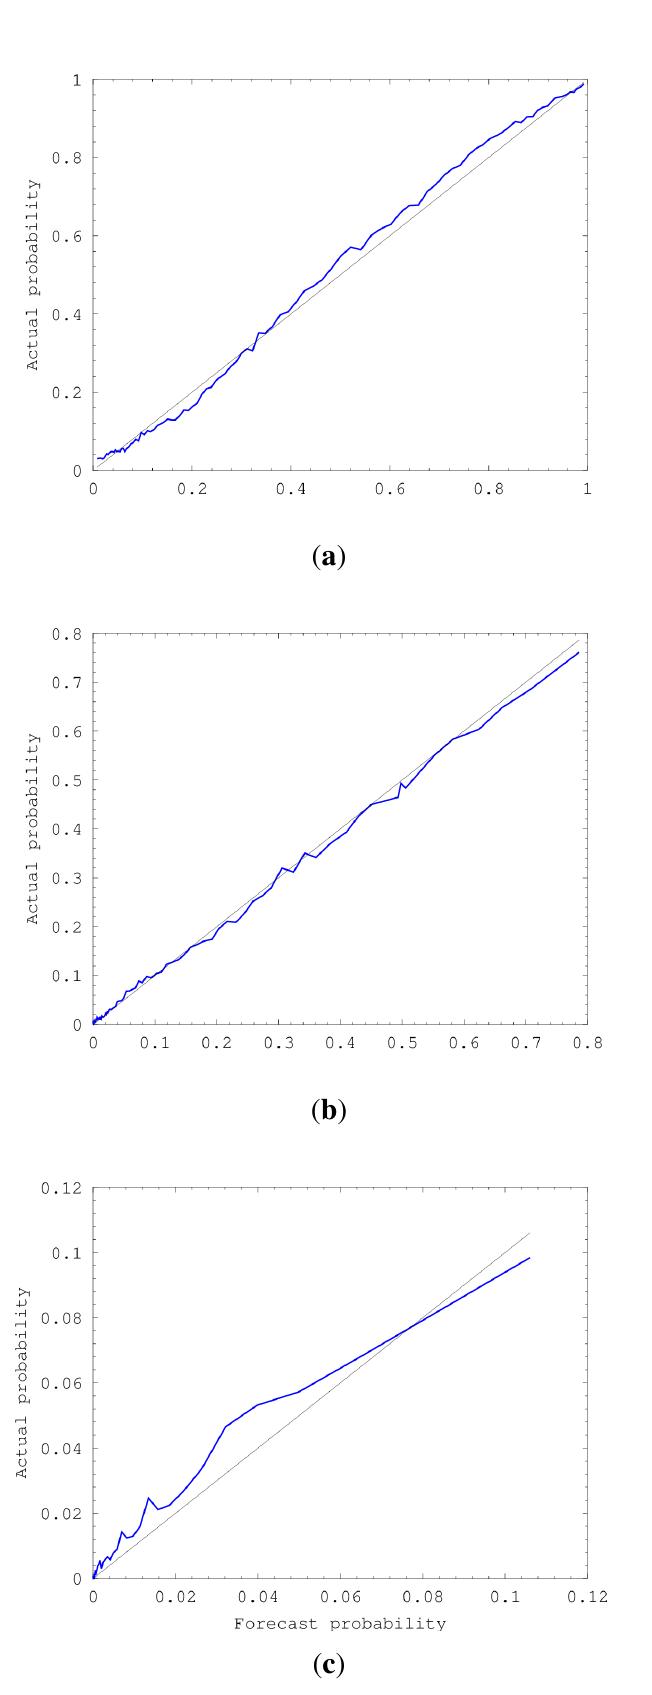
Figure 8. Frequency of precipitation above different threshold values (( a ) 1; ( b ) 10; ( c ) 50 mm/day) as a function of modeled probability (combined satellite and climatology model). 1-1 lines indicating an ideally calibrated model are also